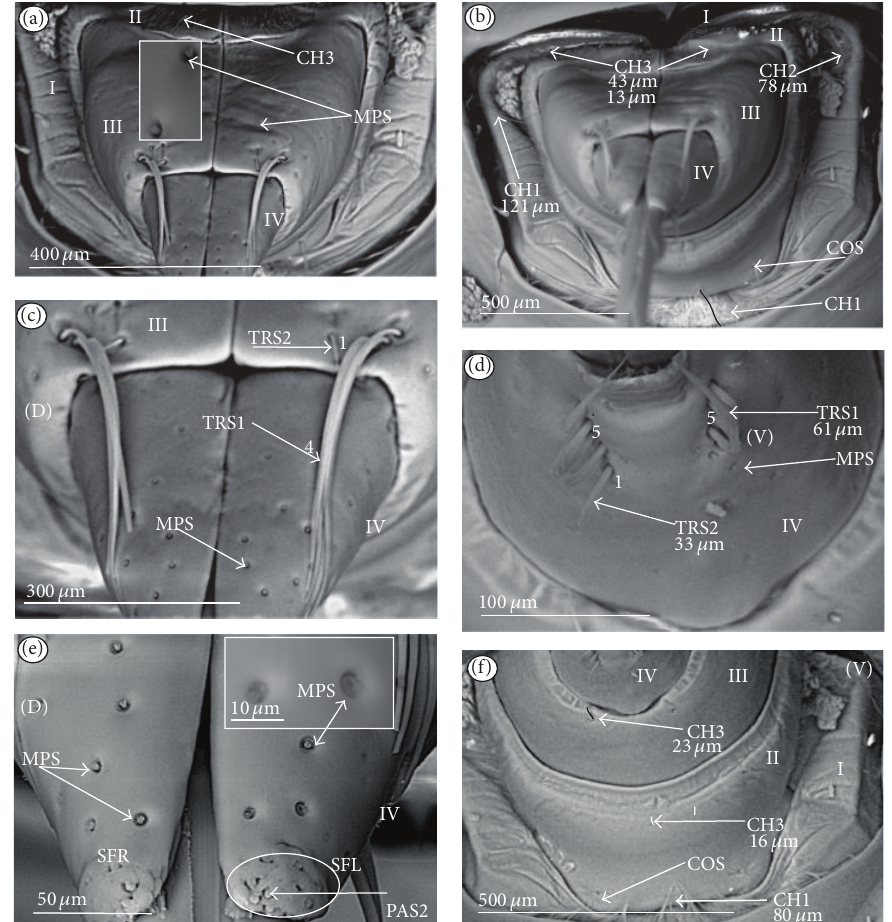
Figure 23: Types and sizes of the sensilla of the Naucoridae: Cryphocricinae ( Ambrysus occidentalis ). (a) MPS are less numerous and spread evenly over the III segment (dorsal view); several CH3 are present on the II segment (dorsal view). (b) CH2 and CH1 cover the dorsal and ventral surfaces of the I segment; COS are situated ventrally on the II segment. (c) TRS1 (four) and TRS2 (one) are situated on the dorsal side (D), in one tuft located distally on the III segment. (d) TRS1 (five) and TRS2 (one) are distributed over the ventral side (V) in one row near the apex of the labium. (e) MPS are less numerous and distributed evenly over the IV segment (dorsal view); PAS2 are distributed on the labial tip (SFR, SFL). (f) One pair of CH3 is situated ventrally near the distal edge of the III and II segments, CH1 are situated oil the edge of the I segment on the ventral side, and COS are located on the II segment on the